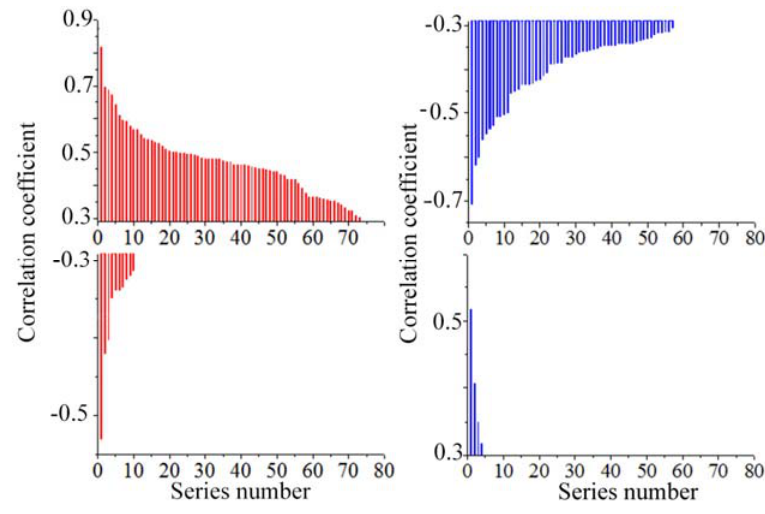
Fig. 6: Correlation between MXD and UV-B (left) and between MXD and IDM (right) Table 2: Principal components distributed over groups: I) MXD series of UV-В-responsive trees and II) MXD series of climatic-responsive trees Factor